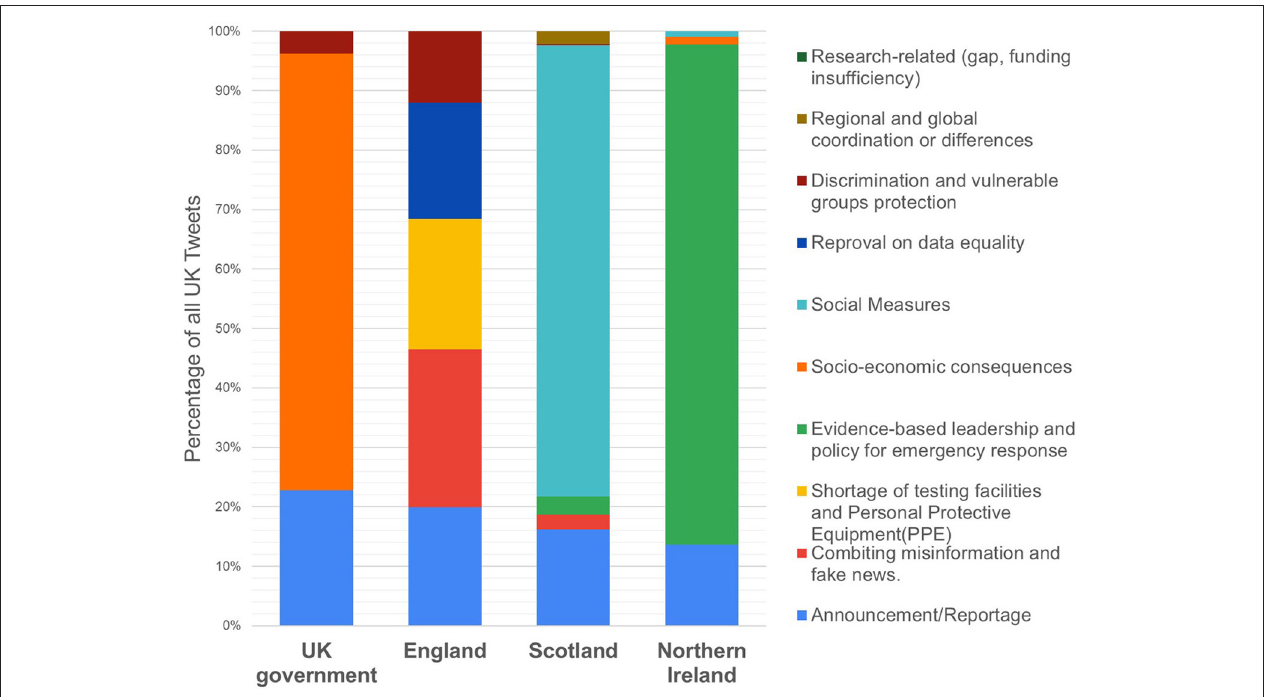
FIGURE 7 | Themes discussed in each UK